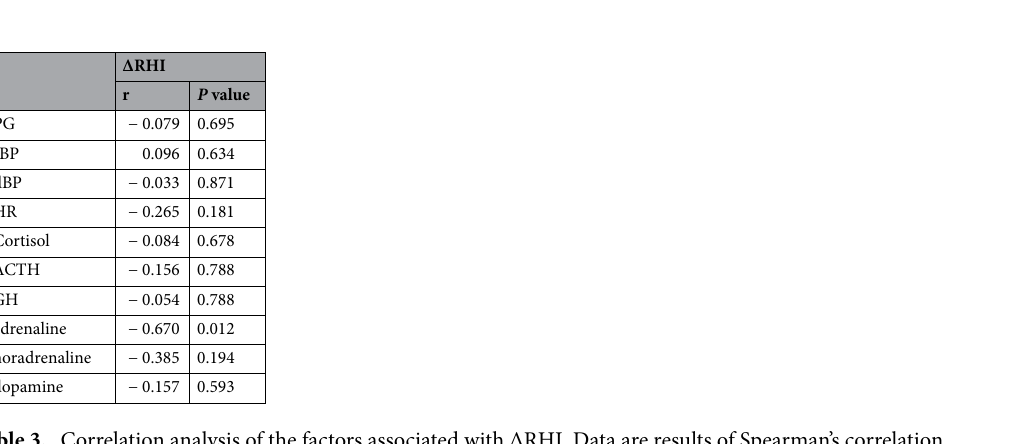
Table 3. Correlation analysis of the factors associated with ΔRHI. Data are results of Spearman’s correlation analysis. RHI, hyperemia peripheral arterial tonometry index; sBP, systolic blood pressure; dBP: diastolic blood pressure; HR, heart rate; PG, plasma glucose; ACTH, adrenocorticotropic hormone, GH, growth